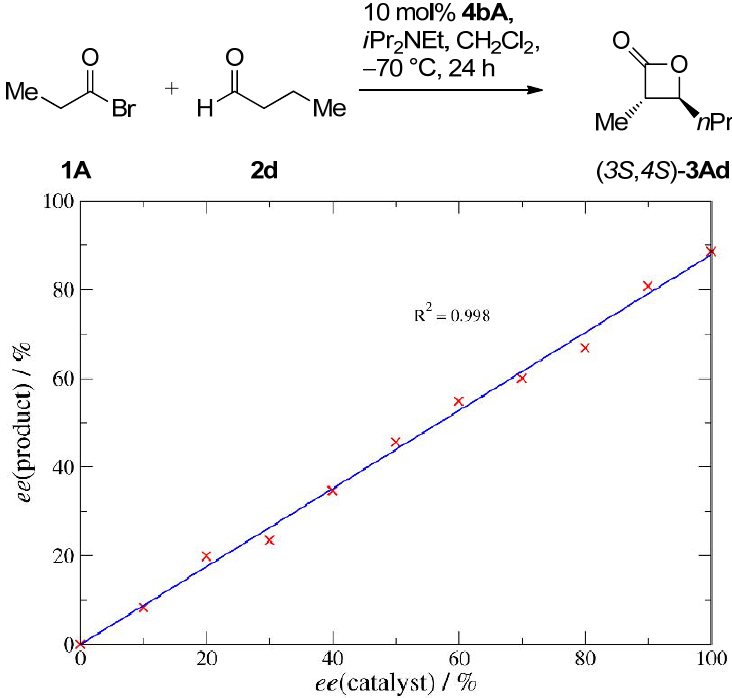
Figure 3. Investigation of a potential nonlinear effect for the formation of 3Ad catalyzed by 4bA